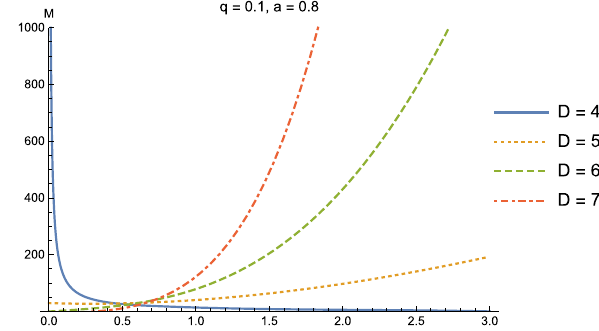
Fig. 11 Mass in Gauss–Bonnet gravity as function of r h , for a = 0 . 8 and q = 0 . 1